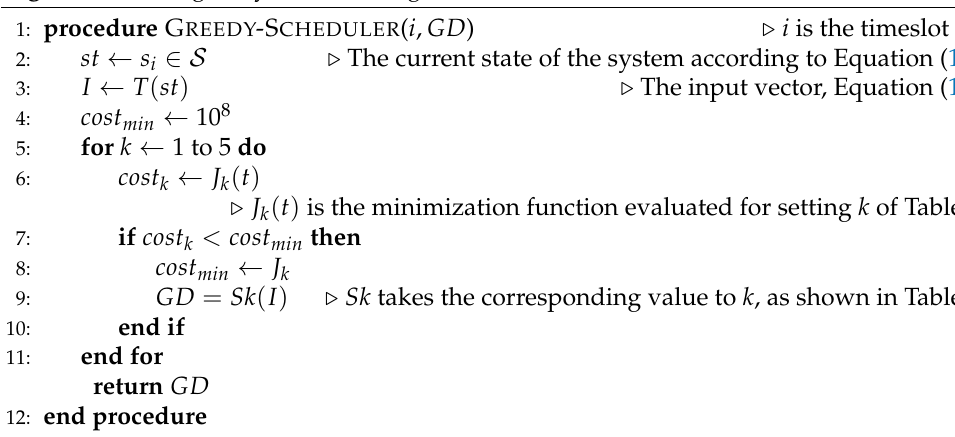
Algorithm 1 The greedy scheduler